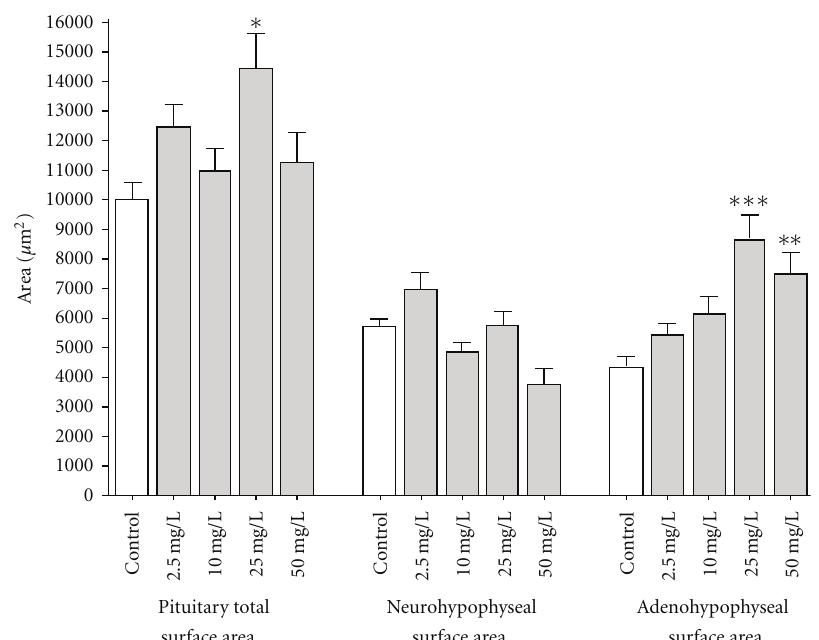
Figure 8: Pituitary surface areas of zebrafish ( Danio rerio ) after exposure to 0, 2.5, 10, 25, and 50mg/L PTU. Measurements were performed with 60 animals after 35 days of exposure. Asterisks indicate significant di ff erences between exposure and control groups ( ∗ P < 0 . 05, ∗∗ P < 0 . 01, ∗∗∗ P < 0 . 001; Dunn’s test).